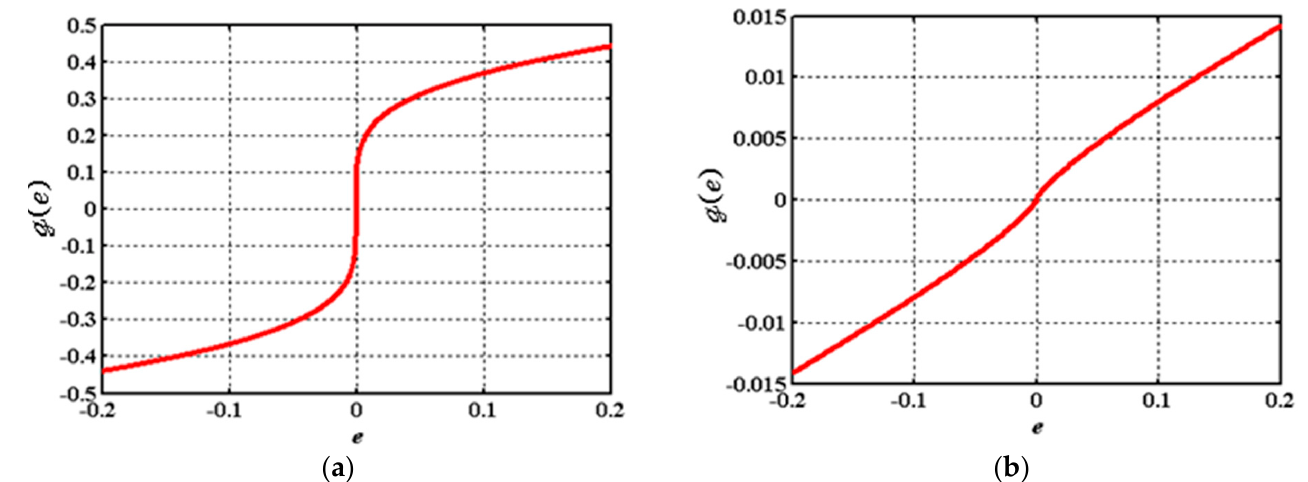
= 0.05, and 𝑘 = 0.05. (cid:3080) (cid:3081)